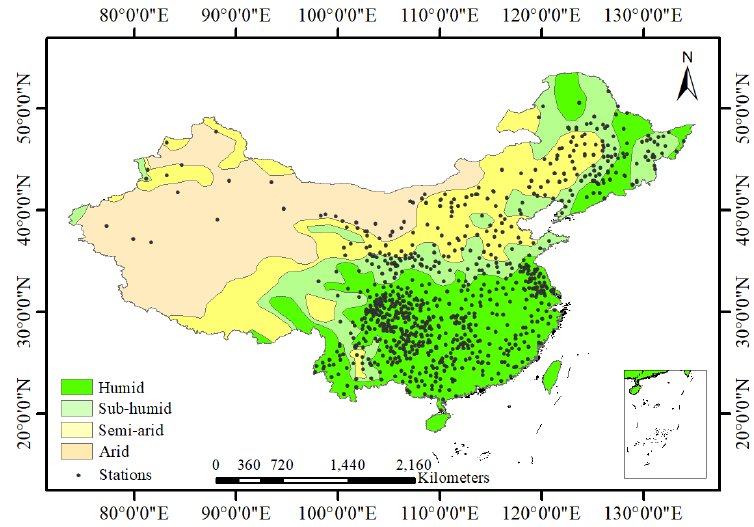
Figure 1. The spatial distribution of arid and humid regions and 893 monitoring stations in China.